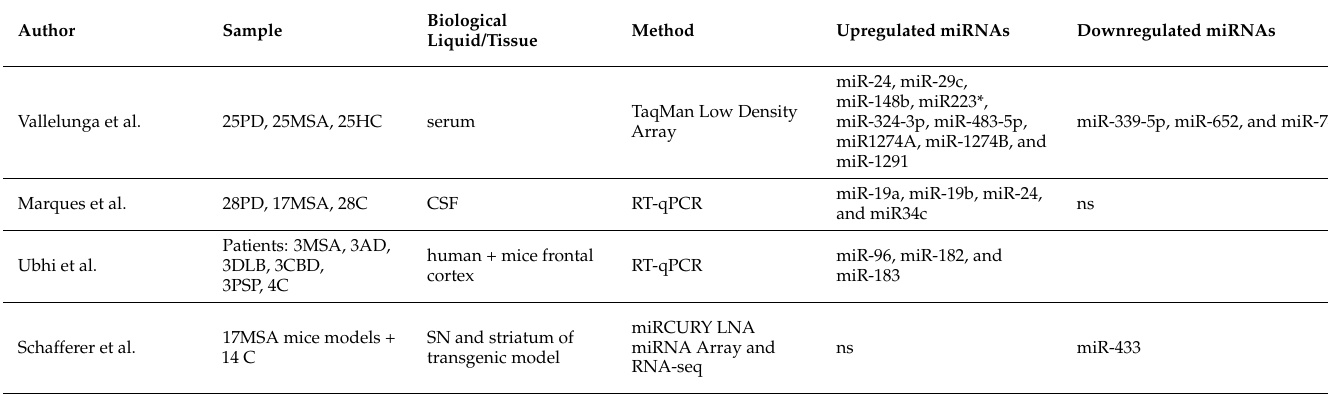
Table 1. Overview of microRNAs in MSA patients and animal